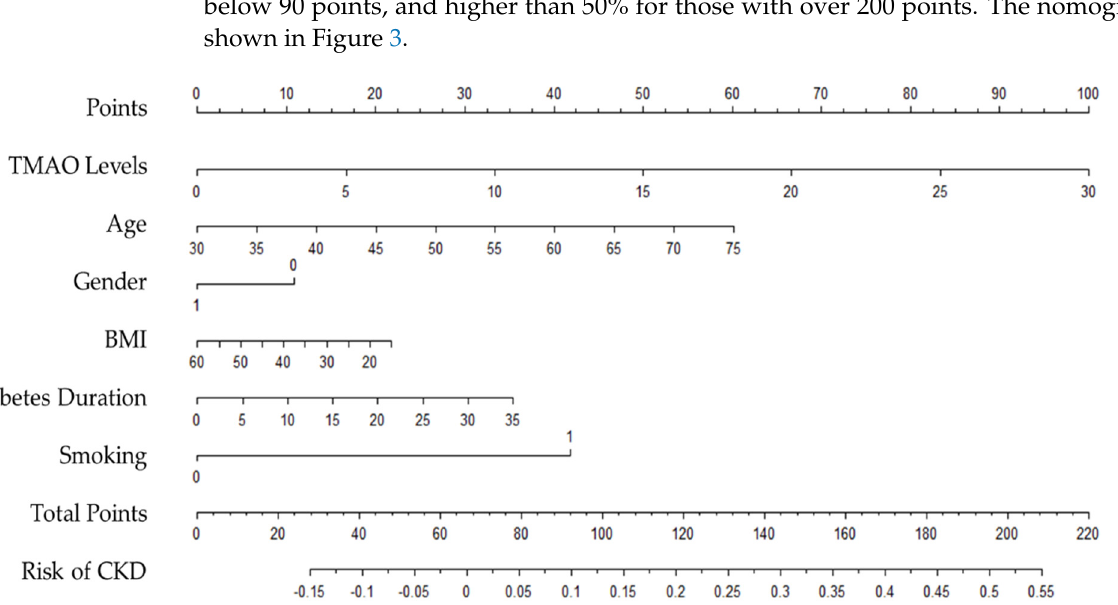
Figure 3. Nomogram to predict the risk of CKD in people with type 2